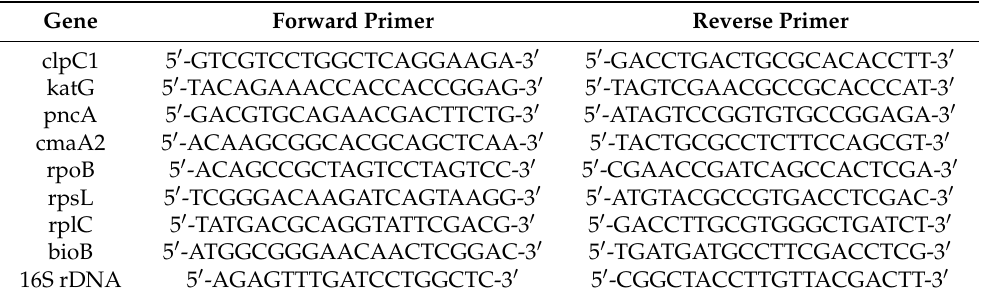
Table 1. qPCR primer